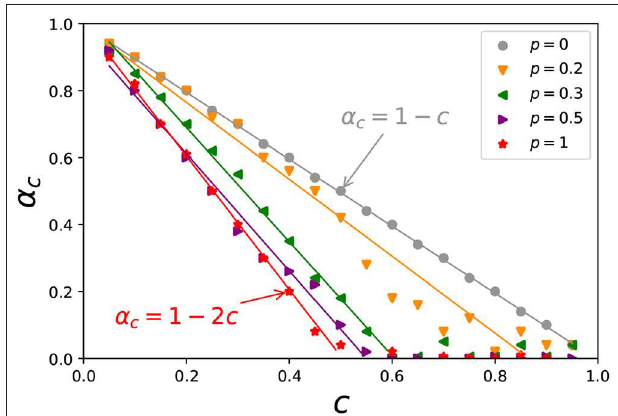
FIGURE 6 | The relationship between α c and c when randomizing the stock-investor network. p denotes the proportion of which the edges in the original network are randomized. The results for different p are shown in different colors and marker shapes, along with lines of best fit (results with α c ≈ 0 are neglected in the lines of best fit). For each p , we delete a proportion of p edges in the original network and generate the same amount of edges apart from the 1 − p edges that have been kept in the network. Thus, p indicates the extent of randomization. When p = 1, for example, random bipartite networks that possess the same amounts of nodes and edges with the real network are generated. On the contrary, when p = 0, there is no randomization and the original network is completely kept, which will give us the results in Figure 2A . All the edge weights are set to be equal in the randomization experiments for simplicity. The initial attacked stocks are also randomly selected to initiate the contagion procedures and the procedures are repeated 600 times for each p . Note that the slope of the linearity between α c and c is − 2 in the most random design. The reasons are that, first, under the circumstance of a dense network, the market value of the failed stock is extremely small compared to the market value of all stocks one investors hold, so P f ∈ F τ w f , m , τ = 0 A m ,